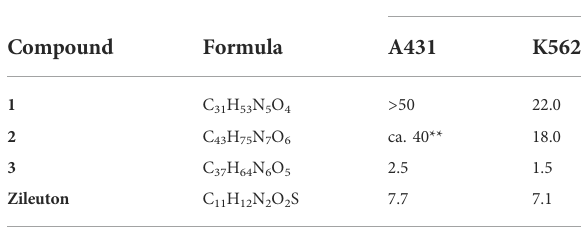
TABLE 2 In vitro cytotoxicity (IC 50 ) of isolated compounds against A431 and K562